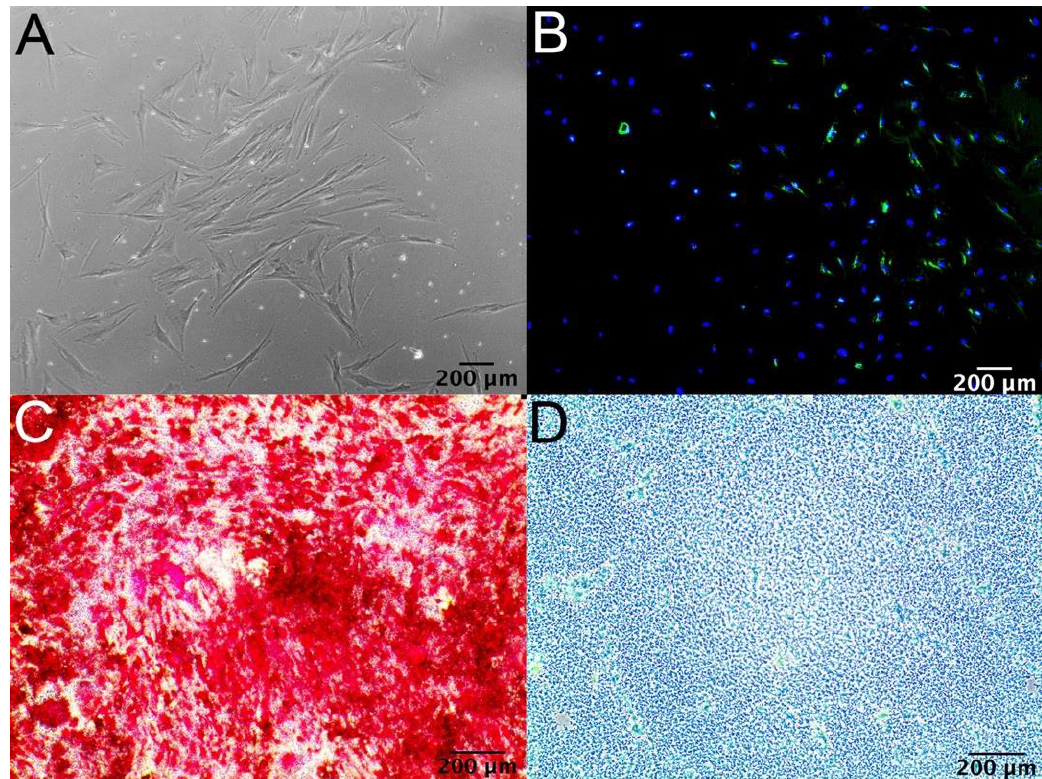
Figure 3. ( A ) Micrograph representing bone marrow-derived MSCs. ( B ) Adipocyte differentiation of MSCs with LipidTOXTM Stain. ( C ) Osteoblast differentiation of MSCs with Alizarin Red S stain. ( D ) Chondrocyte differentiation of MSCs with Alcian Blue stain.